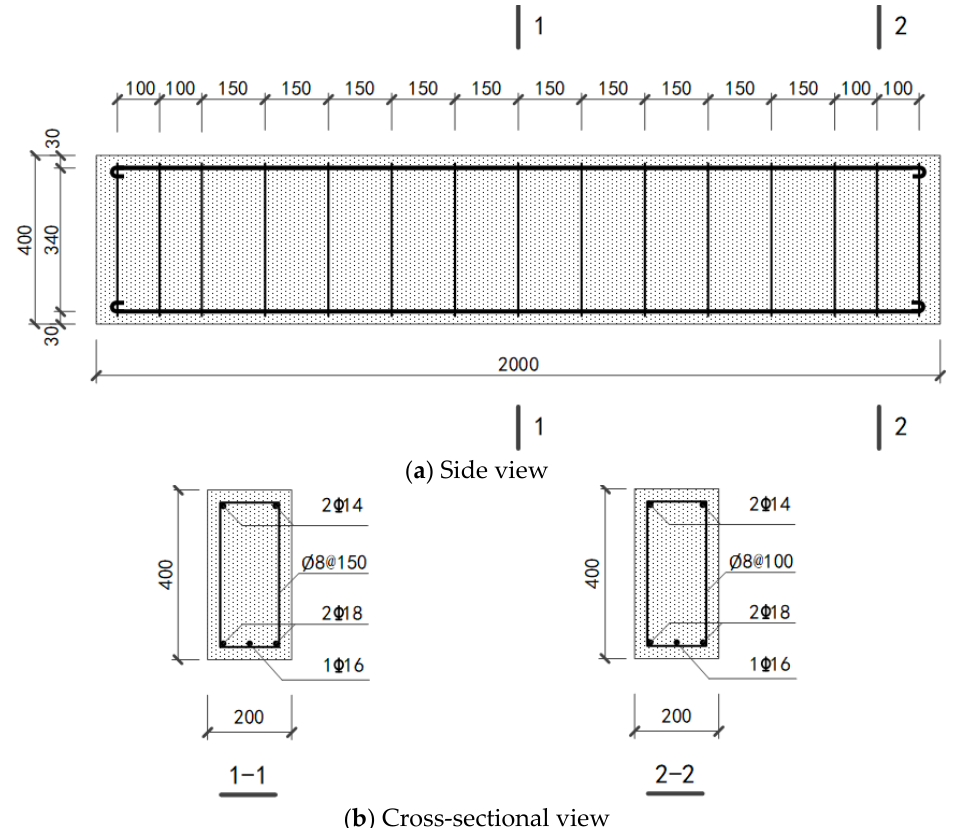
Figure 1. Beam specimen configuration from ( a ) side and ( b ) cross-sectional views (unit: